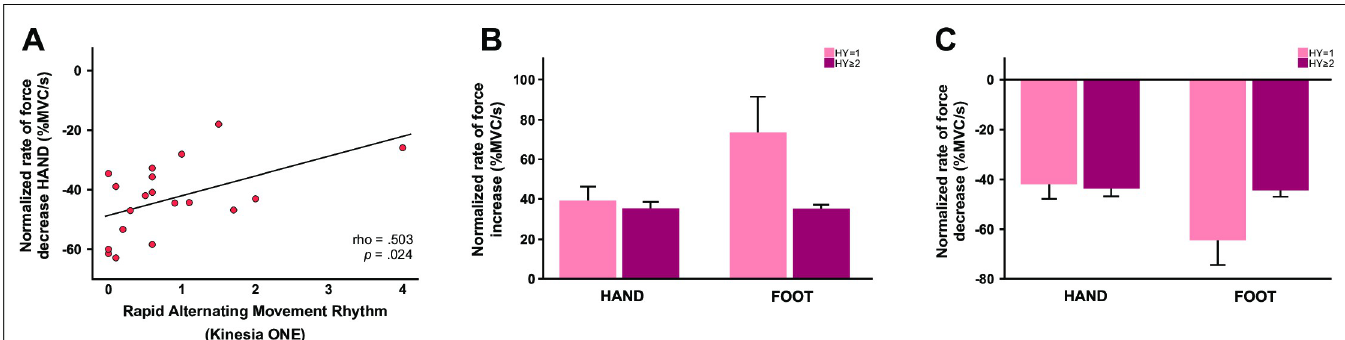
Fig 4. (A) A Spearman’s Rank-Order correlation analysis revealed a significant correlation in PD between the severity of rhythm impairment during the pronation- supination task from the Kinesia ONE protocol and the rate of force relaxation during the hand task. (B) Normalized rate of force increase for the hand and foot tasks broken down by Hoehn and Yahr stage. (C) Normalized rate of force decrease for the hand and foot tasks broken down by Hoehn and Yahr stage. As one can see in the bar graphs which indicate the mean ± 1 SE, PD with a Hoehn and Yahr stage 1 (unilateral symptoms) were faster at generating and releasing force during the foot task than PD with a Hoehn and Yahr stage � 2 (bilateral symptoms). There was no association between the progression staging system in PD and performance on the hand task. Abbreviations: HY = Hoehn and Yahr Staging